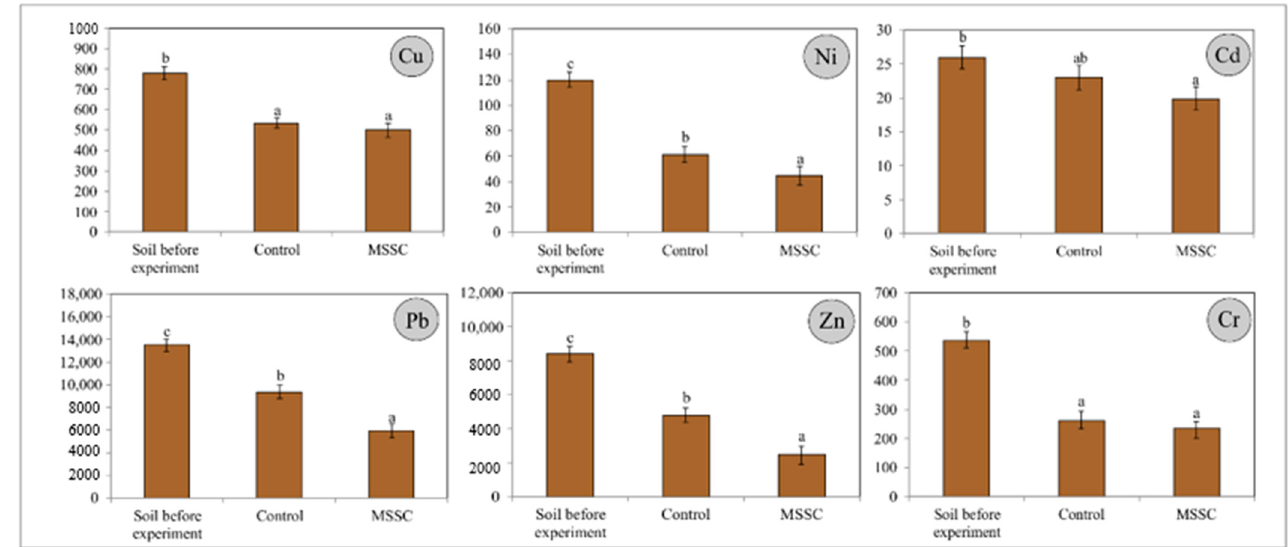
Figure 4. Contents of Cu, Ni, Cd, Pb, Zn, and Cr in the soil after the experiment (n = 3, mean ± standard deviation). For a given HM, different letters indicate significant differences in HM content in soil before experiment, control soil and MSSC-amended soil.